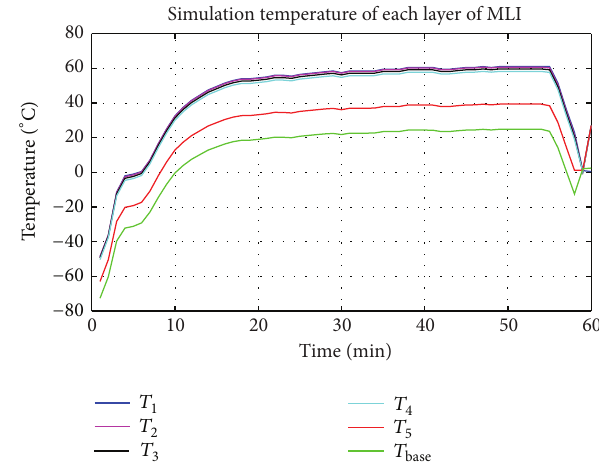
Figure 10: Test temperature data of test specimen 1.